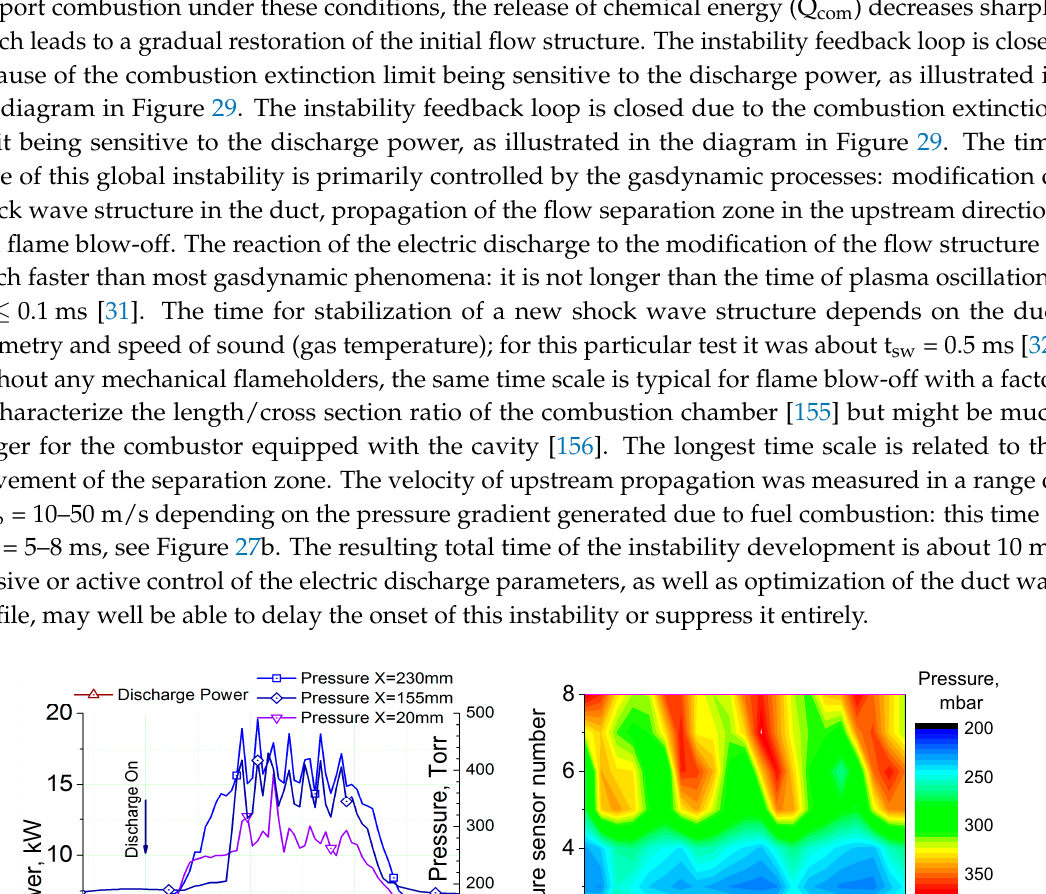
Figure 29. Diagram illustrating a feedback loop of combustion instability development. Small vertical arrows show an increase (up) or reduction (down) of parameter values. Larger inclined arrows show the sequence of processes involved.